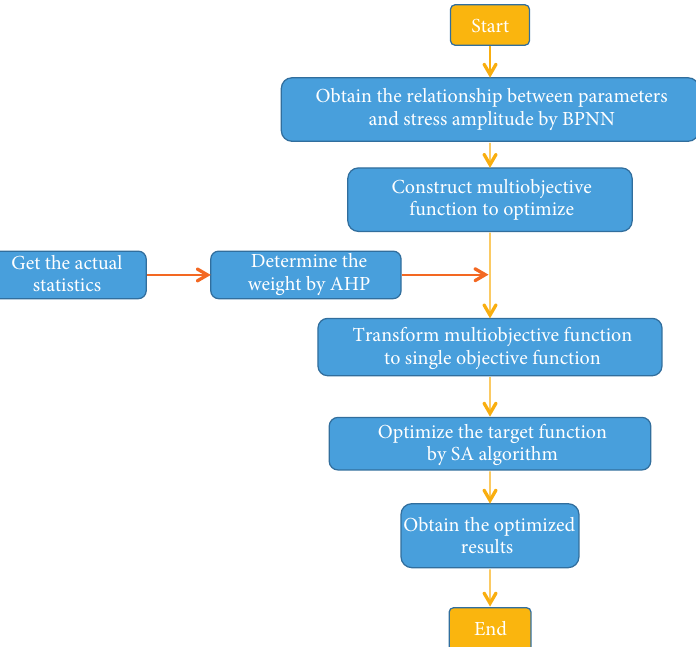
Figure 14: Workflow of BP-SA-AHP method.